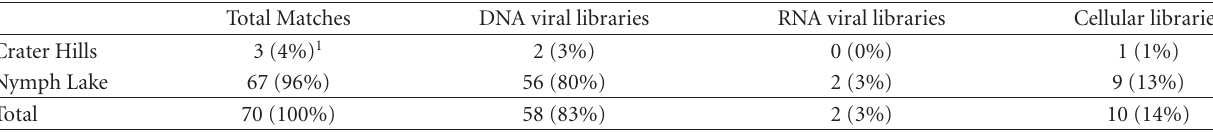
Table 2: Characteristics of the c92 matches to YNP metagenomes.